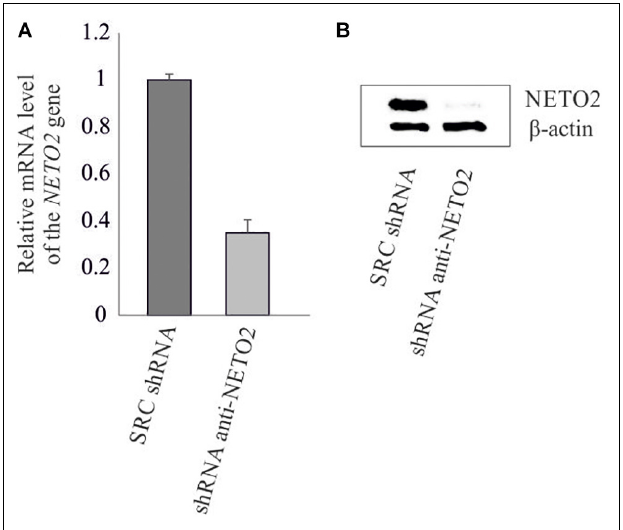
FIGURE 2 | shRNA-mediated knockdown of NETO2 in the HCT116 cell line. Relative NETO2 expression in HCT116 cells transfected with targeting shRNA and non-specific SCR shRNA was measured using qPCR at mRNA level (A) and western blotting (B) at the protein level.